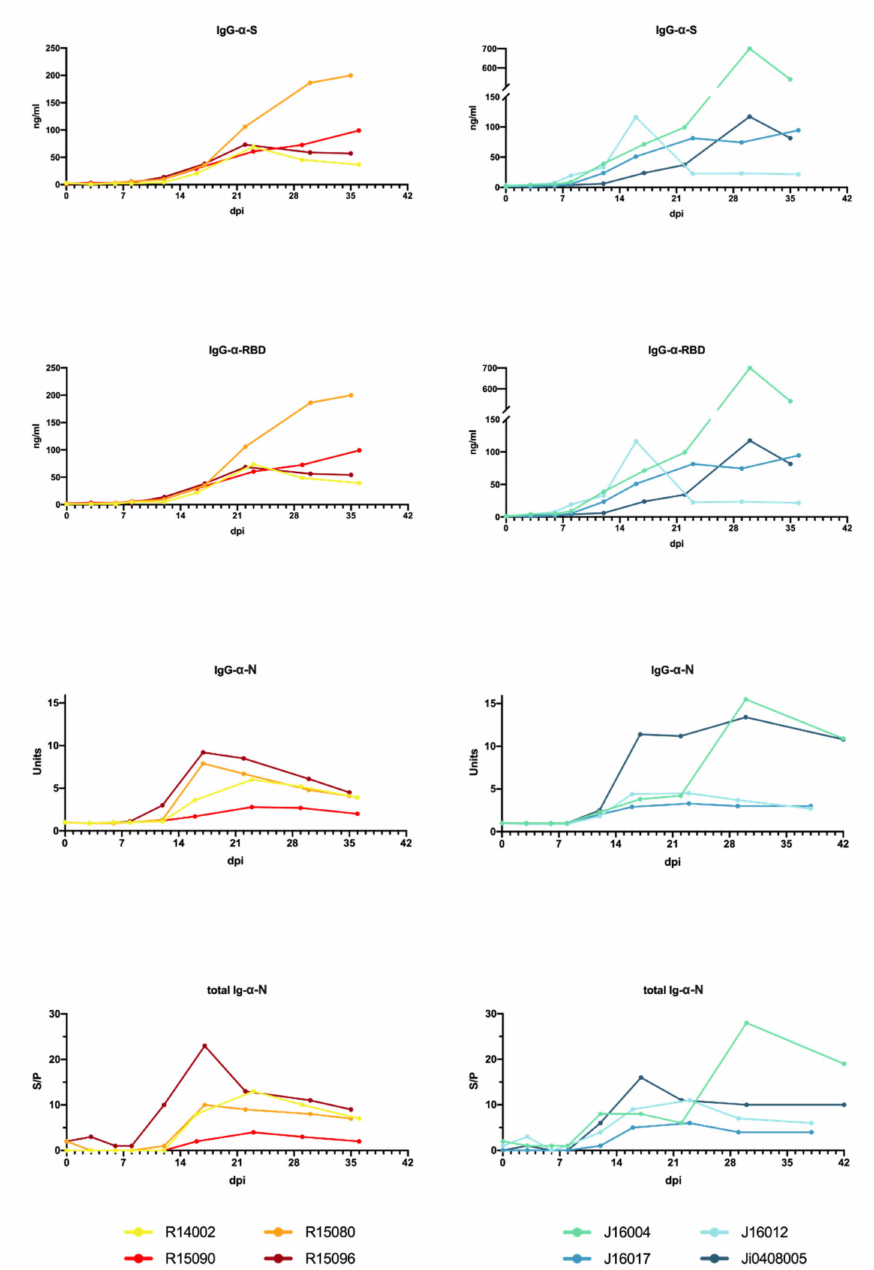
Figure 3. Development of a SARS-CoV-2 antibody response in rhesus and cynomolgus macaques. The humoral immune response was determined using an anti-S IgG ELISA, an anti-RBD ELISA, a serological test to detect IgG directed to the N protein, and a DR-ELISA measuring the total antibody response to N (left to right). Results of DR-ELISA are shown as S/P: sample to positive control ratio: S / P = test sample − mean negative control and Units = test sample at x dpi mean positive control − mean negative control test sample at 0 dpi